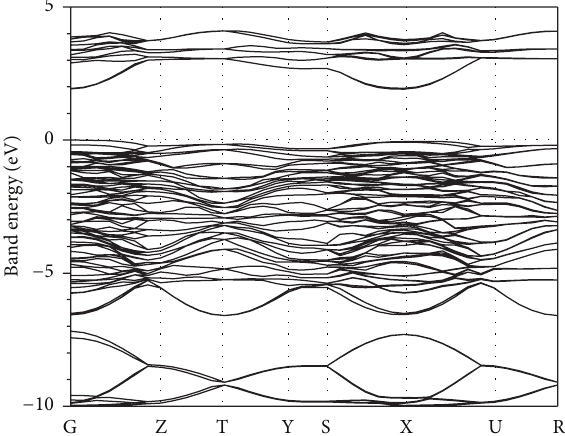
Figure 7: Band gap of Bi 2 WO 6 (simulated by Quantum Espresso [22]).